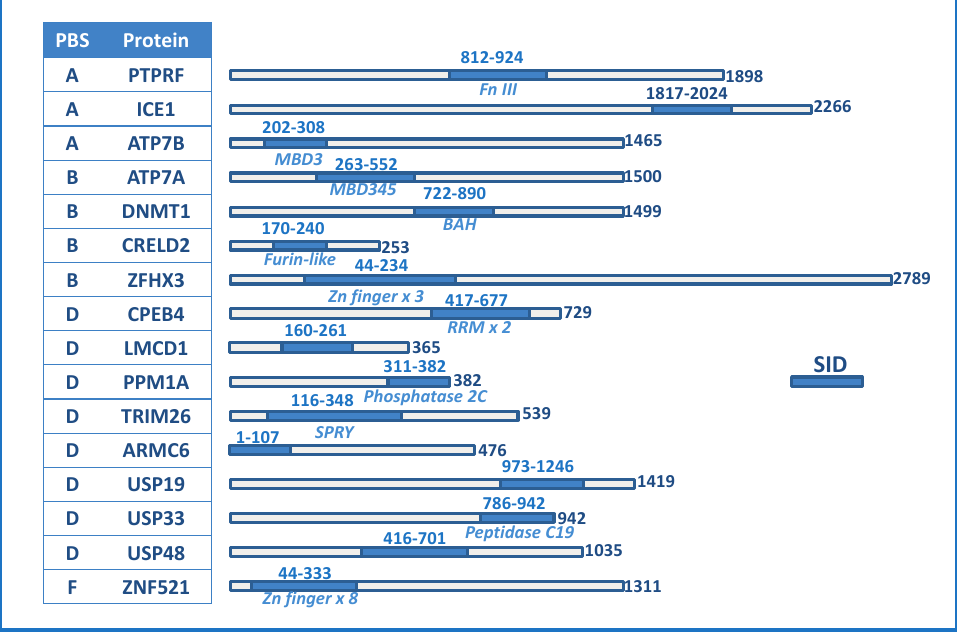
Figure 1. Predicted Biological Score (PBS) score, name, and SID domain boundaries for Atox1 identified interaction partners. The length of each protein is given and, if the SID overlaps with a known domain, this is listed in italics under the SID. Only SIDs are annotated in terms of known domains but for many of the proteins additional domains are predicted/known. Fn III, fibronectin domain 3; MBD, metal-binding domain; BAH, bromo-adjacent domain; Zn,